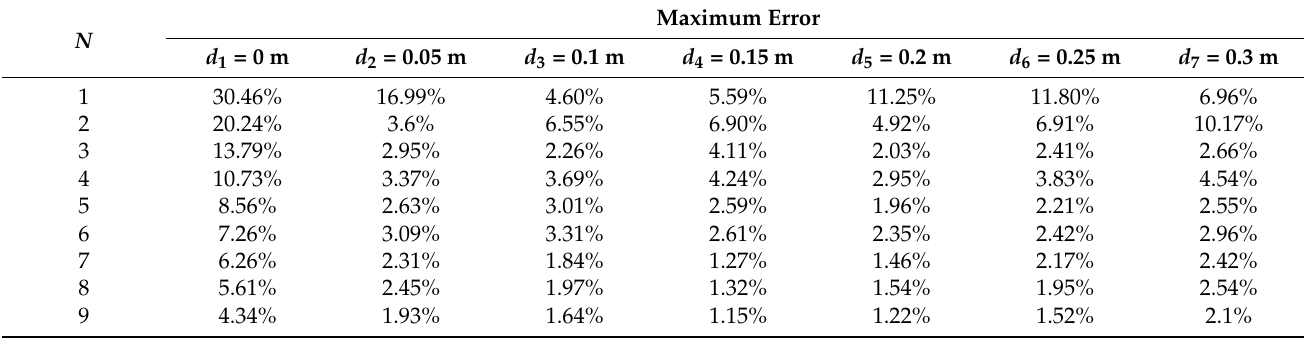
Table 3. Error statistical results.